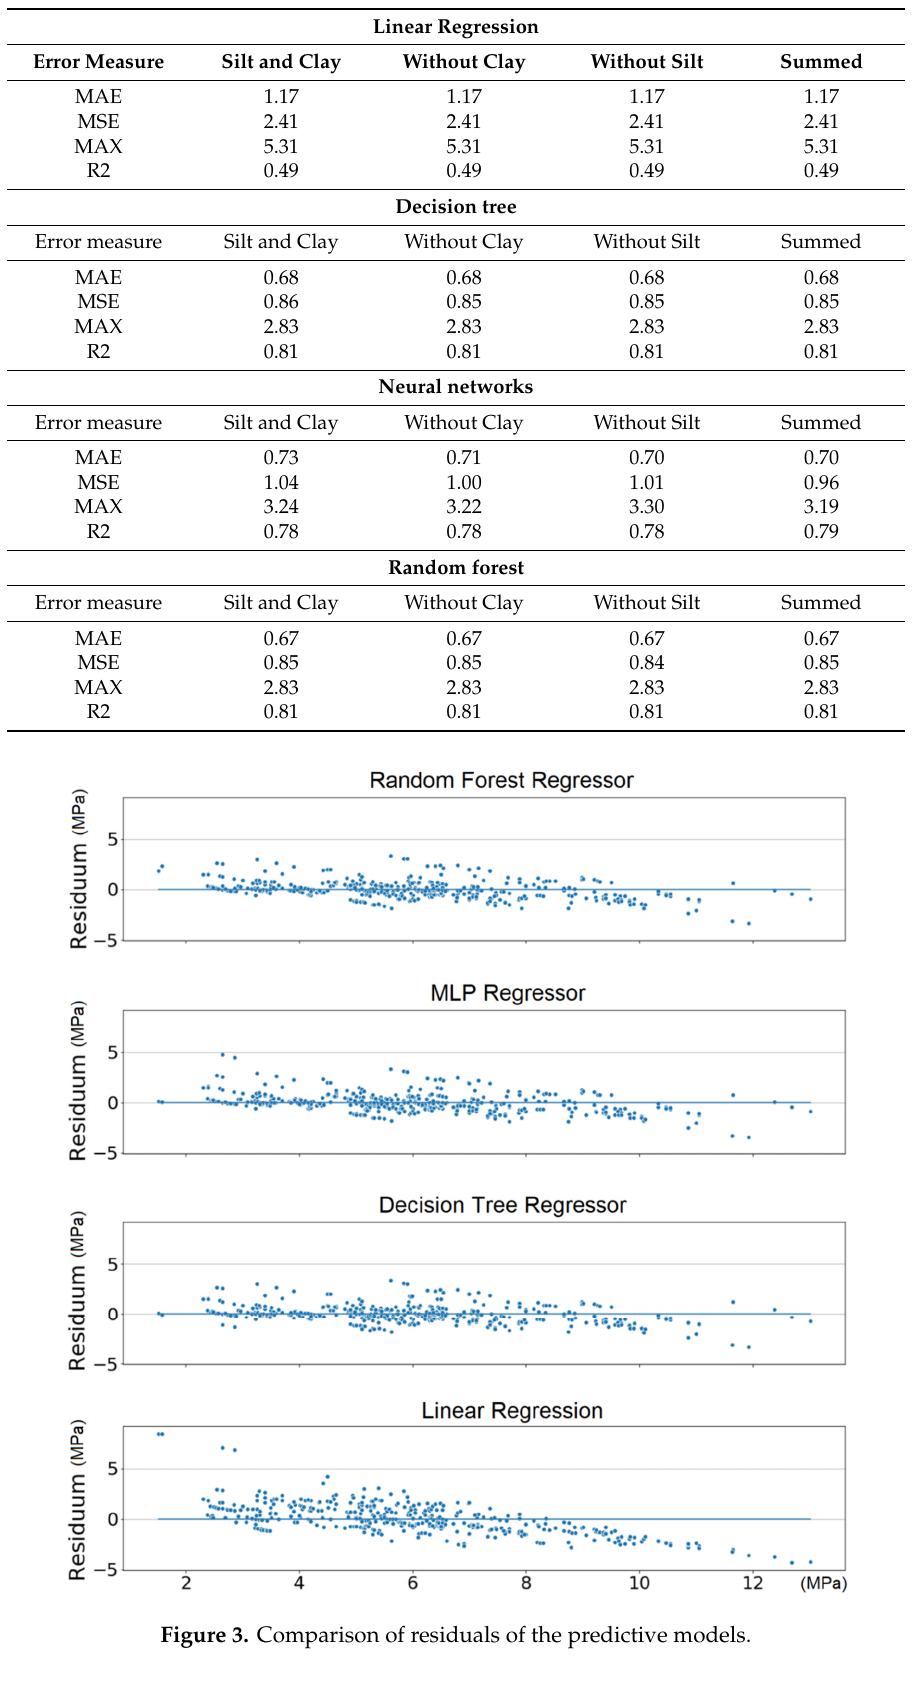
Table 3. Performance measures’ values of the predictive models.